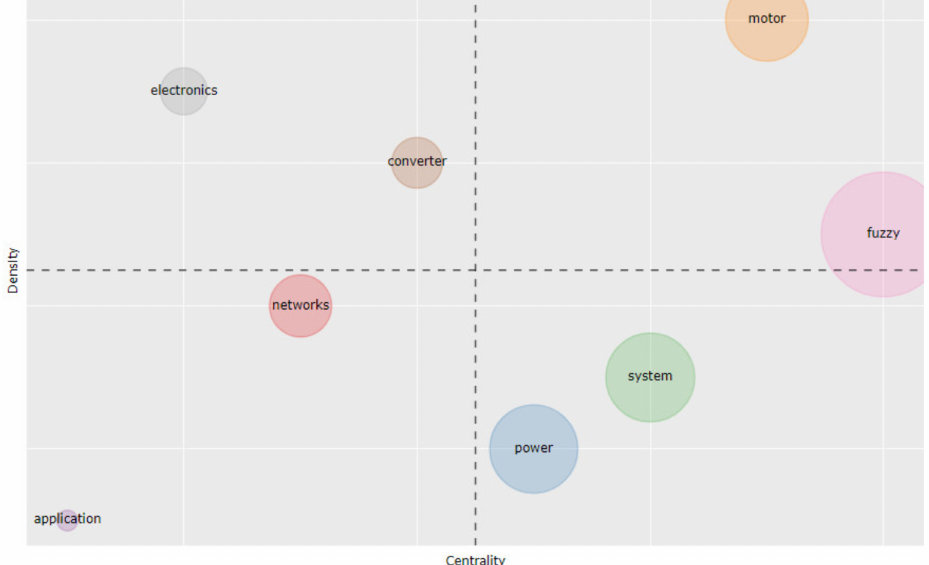
Figure 21. Thematic map based on titles.